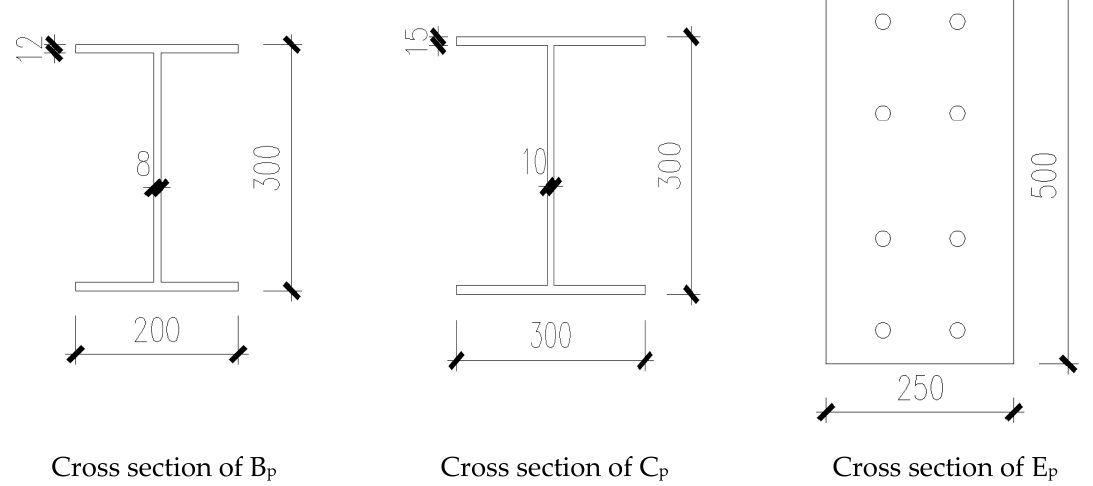
Figure 1. Schematic diagram of component dimensions.